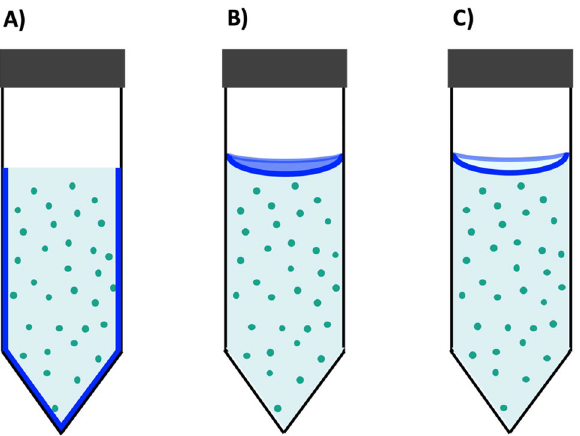
Figure 5. Scheme picturing the three interfaces considered during protein agitation. ( A ) Solid/liquid interface at the material surface. ( B ) Air/liquid interface. ( C ) Triple air/liquid/solid line interface defining the meniscus. Proteins, represented as green dots, could adsorb to one or several of these interfaces during mixing.